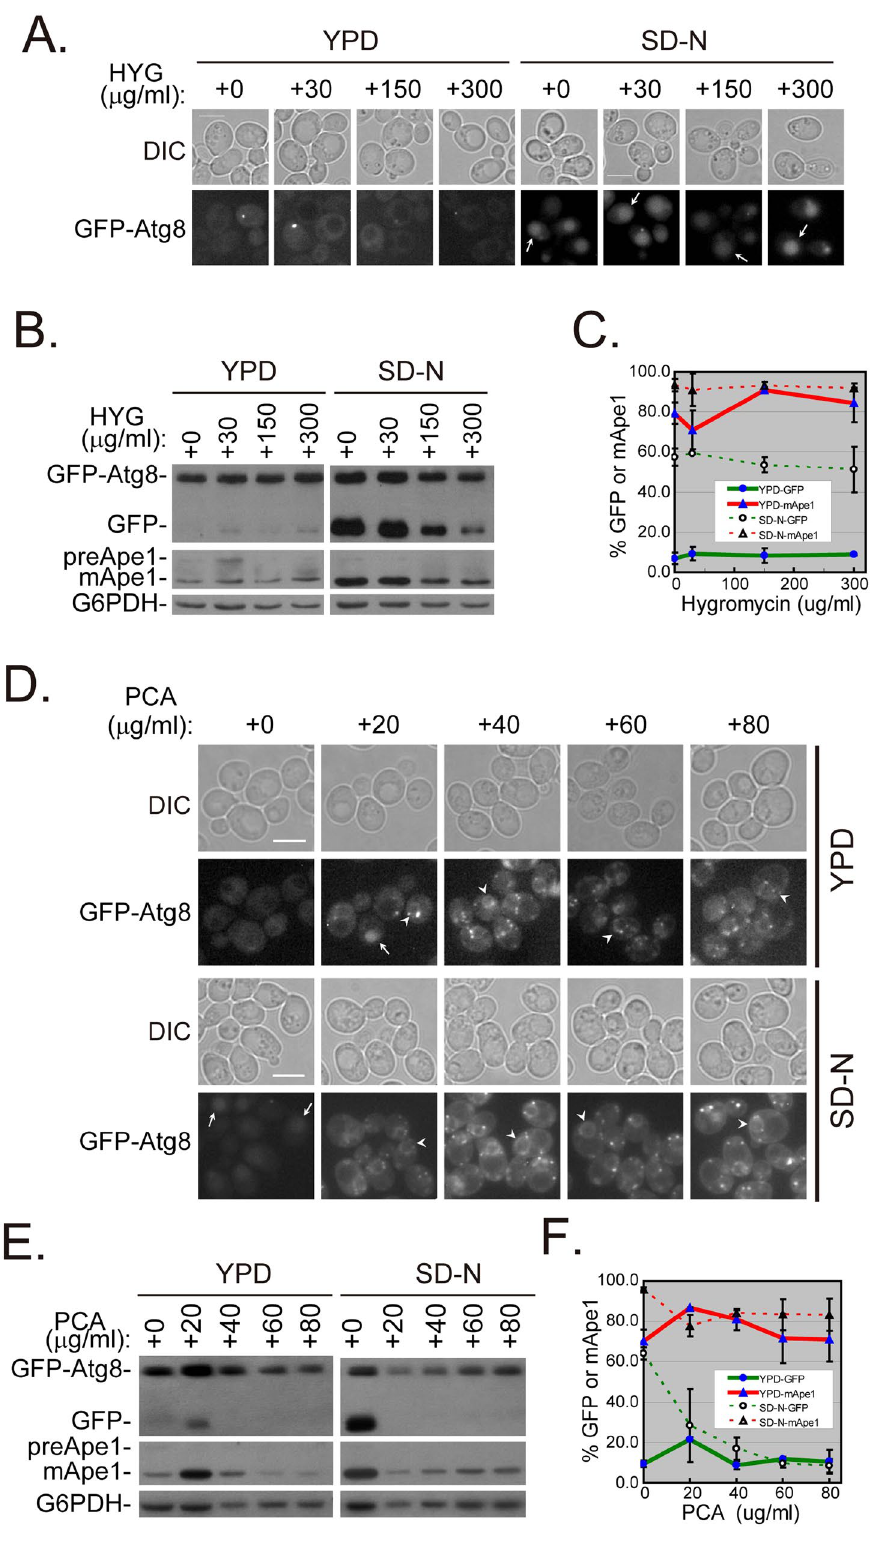
Figure 7. Treatment with PCA alters the autophagy process differently than hygromycin B. ( A ) HYG treatment did not disrupt the localization of GFP-Atg8. ( B ) HYG treatment slightly retarded GFP-Atg8 processing in a dose-dependent manner in SD-N. ( C ) Quantification of blots in panel B. ( D ) PCA treatment altered the localization of GFP-Atg8 in YPD and SD-N differently. ( E ) PCA treatment induced slight autophagy at low PCA concentrations in YPD and impaired autophagy in SD-N. ( F ) Quantification of blots in panel E. PhC, phase contrast. The bar represents 5 μ m. Arrows indicate cells with GFP inside the vacuoles. Arrowheads indicate the ER ring inside the cell. The results shown represent two independent